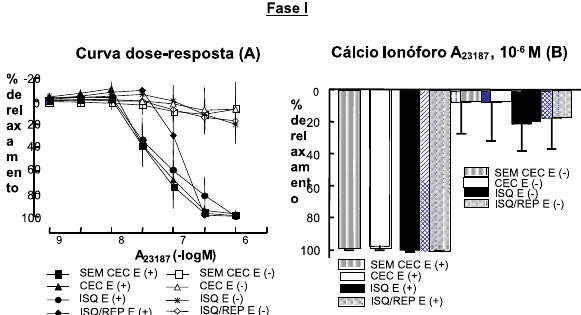
Fig. 7 - Fase I (Krebs com magnésio): A - Curvas dose- respostas cálcio ionóforo (A ) em anéis de artérias coronárias 23187 caninas, contraídas com PGF a (2 x 10 -6 M), na presença de 2 indometacina (10 -5 M); B - Efeitos da dose 10 -6 M de cálcio ionóforo (A ) em anéis de artérias coronárias caninas, contraídas com 23187 PGF2a (2 x 10 -6 M), na presença de indometacina (10 -5 M). (SEM CEC = grupo controle, CEC = grupo de animais submetidos a Fig. 6 - Fase III (Krebs com magnésio restaurado): A - Curvas 110 min de circulação extracorpórea, ISQ = grupo de animais dose-respostas ao fluoreto de sódio (NaF) em anéis de artérias submetidos a 45 min de isquemia, ISQ/REP = grupo de animais coronárias caninas, contraídas com PGF a (2 x 10 -6 M), na submetidos a 45 min de isquemia e 60 min de reperfusão, E (+) = 2 presença de indometacina (10 -5 M); B - Efeitos da dose 9,5 mM de anéis com endotélio, E (-) = anéis sem endotélio. Valores em fluoreto de sódio (NaF) em anéis de artérias coronárias caninas, porcentagem de relaxamento sob a forma de médias ± erros- contraídas com PGF2a (2 x 10 -6 M), na presença de indometacina padrão ). (n = (10 -5 M). (SEM CEC = grupo controle, CEC = grupo de animais submetidos a 110 min de circulação extracorpórea, ISQ = grupo de animais submetidos a 45 min de isquemia, ISQ/REP = grupo de animais submetidos a 45 min de isquemia e 60 min de reperfusão, E (+) = anéis com endotélio, E (-) = anéis sem endotélio. Valores em porcentagem de relaxamento sob a forma de médias ± erros- padrão ). (n = 6).